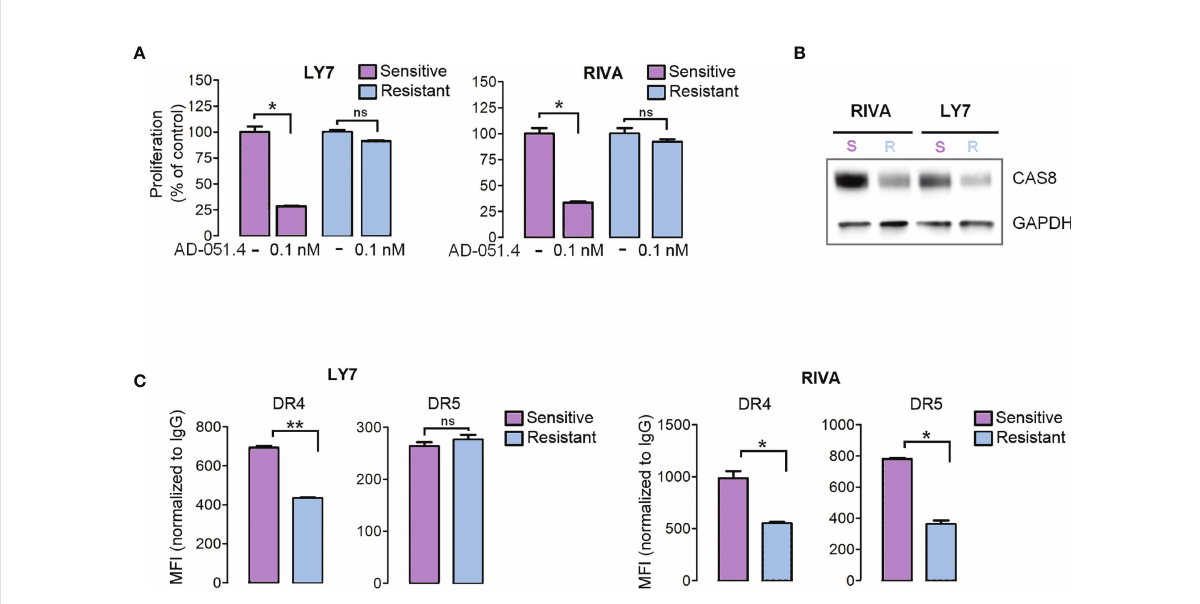
FIGURE 3 Engineered AD-O51.4 - resistant DLBCL cell lines have decreased caspase 8 and death receptor expression. (A) LY7 and RIVA cell lines were incubated with increasing doses of AD-O51.4 until reached complete resistance to 0.1 nM AD-O51.4. The viability of parental (purple bars) and engineered resistant (blue bars) cells is shown. Bars indicate the average of three experiments and error bars represent standard deviations. Results were normalized to untreated (control) cells. (B) Expression of caspase 8 in parental vs resistant LY7 and RIVA cells was assessed by immunoblotting. (C) Surface expression of DR4 and DR5 in parental vs resistant LY7 and RIVA cells was assessed by fl ow cytometry. Boxes represent average MFI from 3 replicates normalized to isotype-matched antibody, error bars represent standard deviations. *p-value<0.05, **p- value<0.005, ns – not signi fi